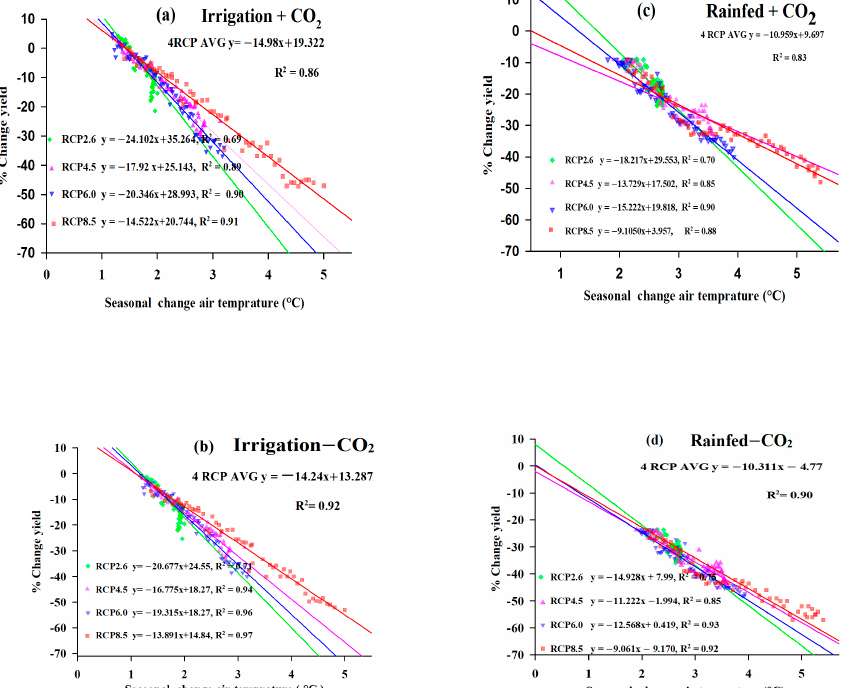
Figure 8. Regression relationships between the temperature and changes in the average yields relative to the baseline yield during the years 2021–2080. ( a ) Irrigation + CO 2 ( b ) Irrigation − CO 2 ( c ) Irrigation + CO 2 ( d ) Rainfed − CO 2.